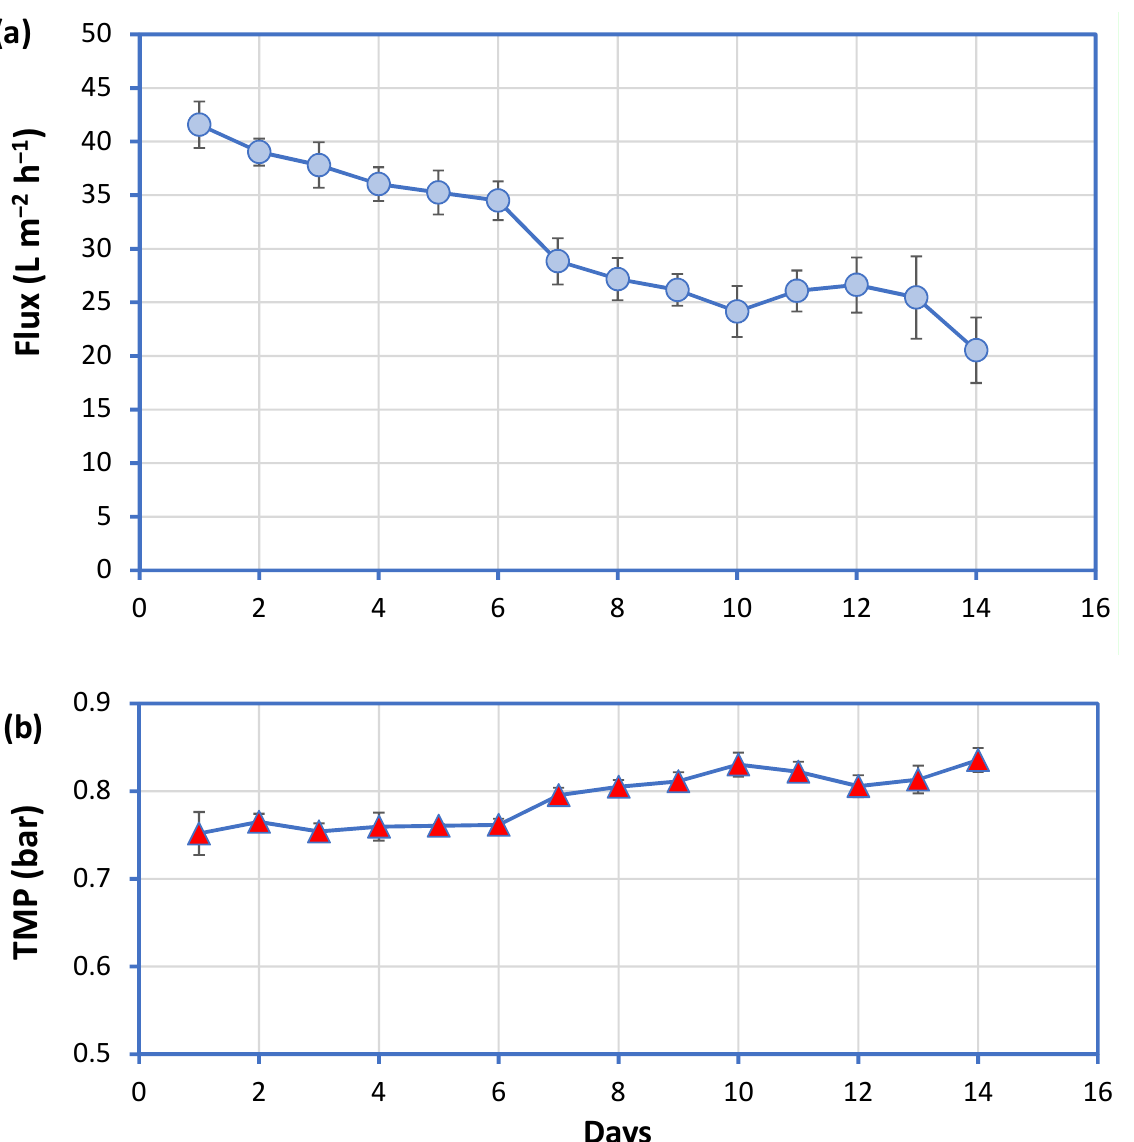
Figure 4. ( a ) Normalized permeate flux and ( b ) transmembrane pressure (TMP) during continuous operation of a micro-scale MBR system treating synthetic greywater.